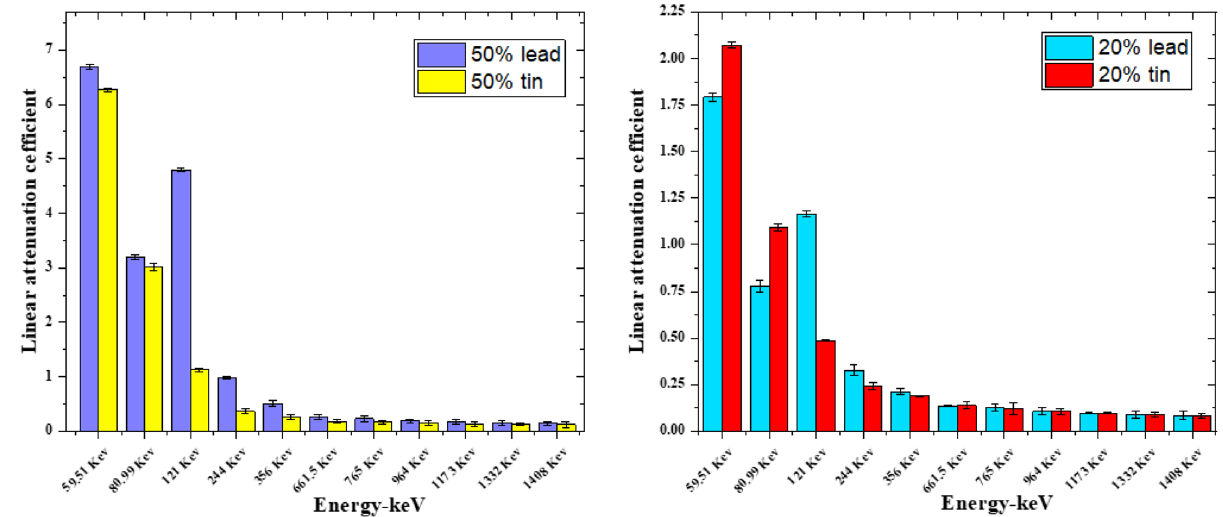
Figure 13. Comparison the LAC between our result and nano-PbO/SR for 20 and 50% concentration at different